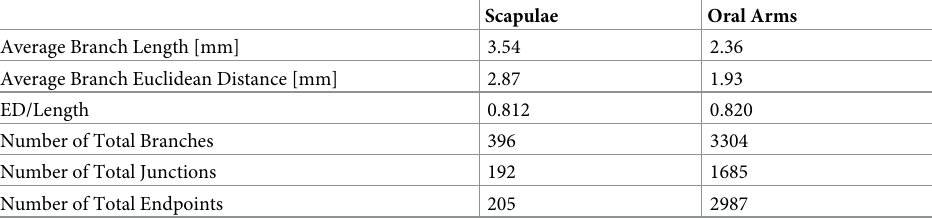
Table 1. Summary of the skeleton analysis